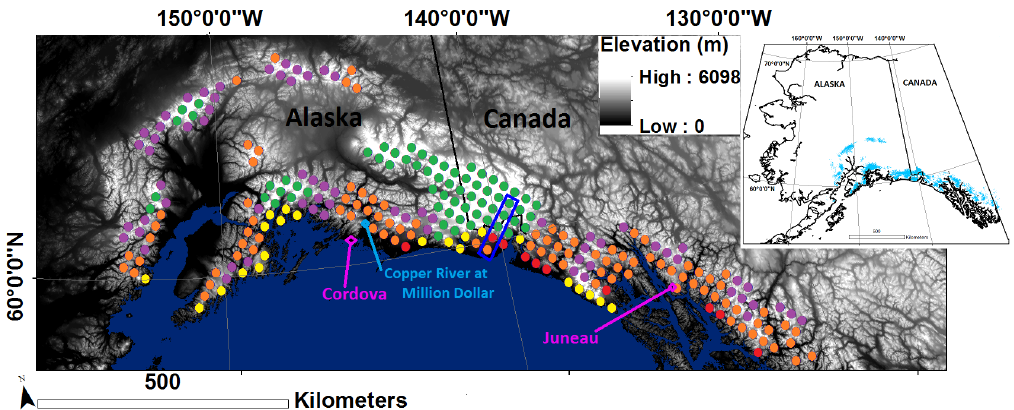
Figure 3. Digital Elevation Model [26] of southern Alaska with locations of pixels analyzed in the study. Dots are the centroid of the 25 km EASE-grid pixels used for the data analysis. Dot colors depict the characteristic melt regime pattern (Figure 1 SSM/I T b colors are the key) determined from the sum and average T 2011. Relatively warmer and wetter melt patterns are found closer to the coast.